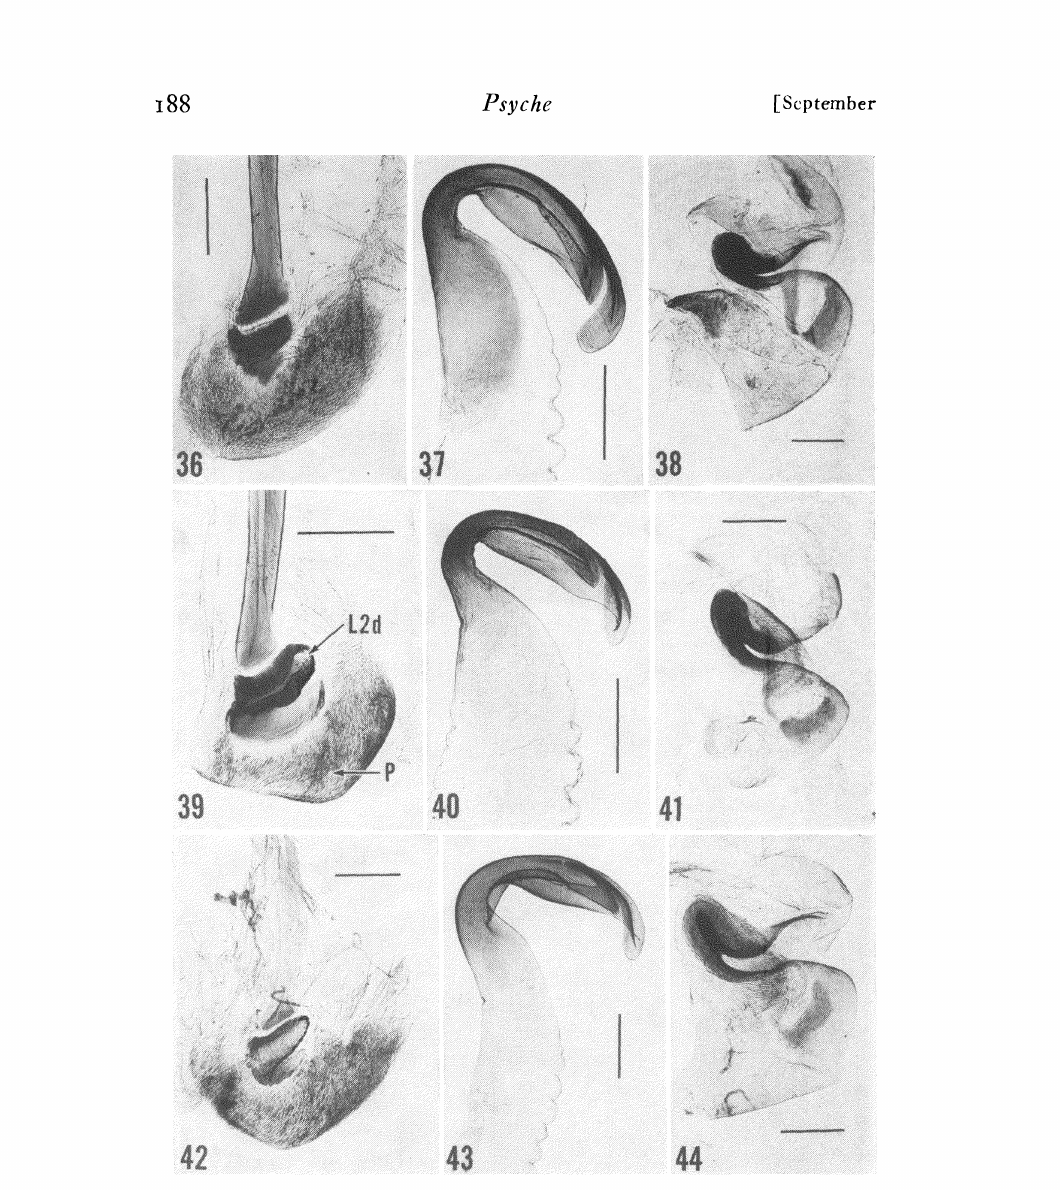
Figs. 36-44. Cockroach male genitalia of Epilamprinae (Epilamprini). 36-38. Litopeltis bispinosa (Saussure). Puntarenas Province, Costa Rica --- (det. Fisk). 39-41. (168 ANSP). L. bislinosa. Porto Bello, Panama (det. Rehn). 42-44. (172 ANSP). Litopeltis biolleyi. (from specimen shown Fig. 7a). (L2d dorsal selerite of L2; P prepuce). (scale 0.3